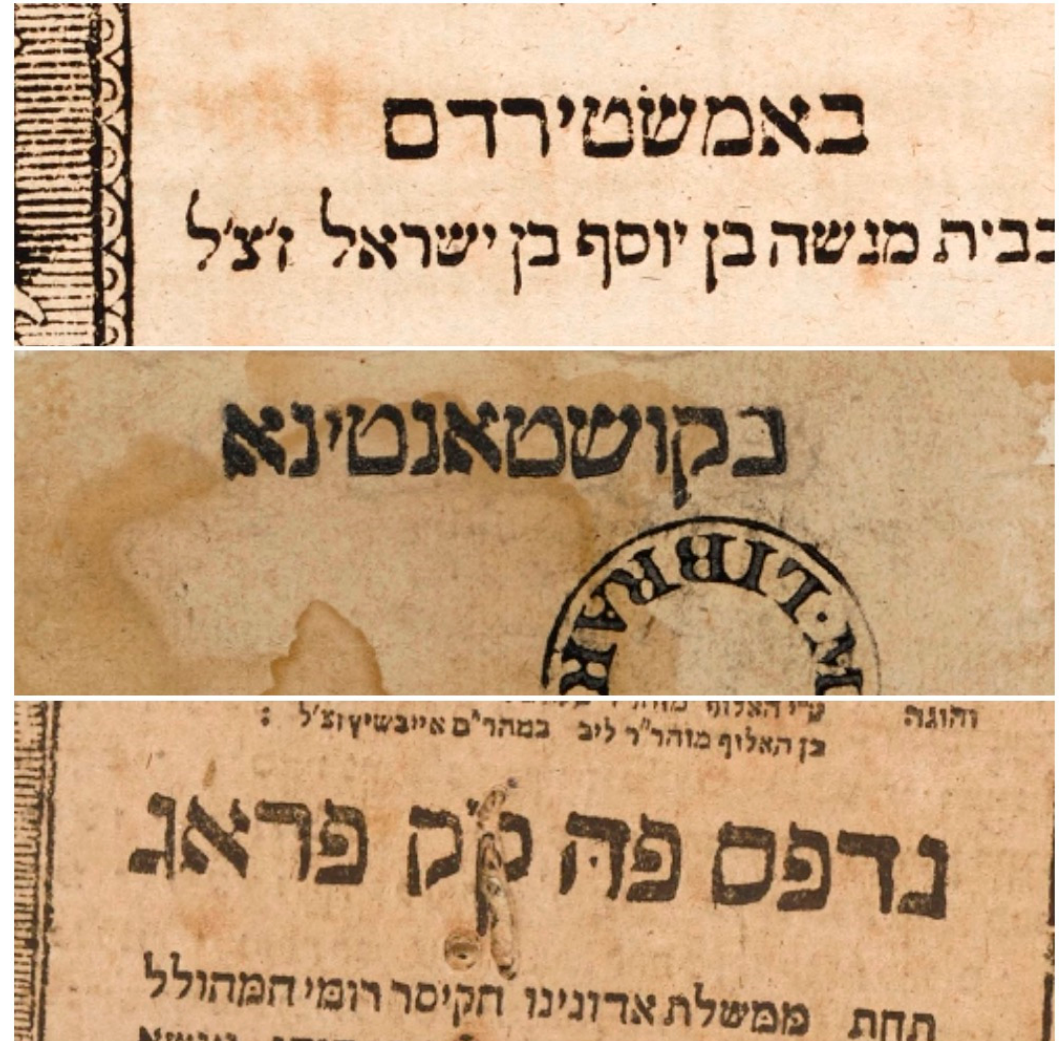
Figure 27. Place of Publication—Amsterdam, Constantinople, and Prague; examples from Marsh’s Library.